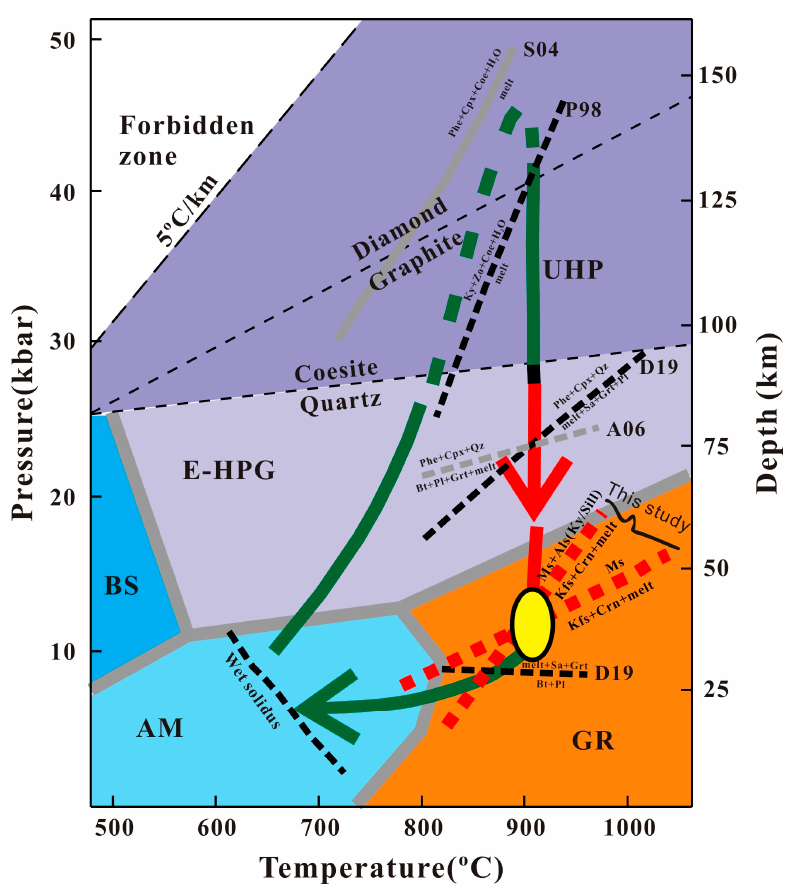
Figure 8. Synthesis of the NDZ P-T path (modified from [70]), with emphasis on the main Figure8. SynthesisoftheNDZP-Tpath(modifiedfrom[70]), withemphasisonthemainmelt-producing melt-producing reactions occurred during isothermal decompression, as inferred from previous reactions occurred during isothermal decompression, as inferred from previous studies (black and grey studies (black and grey dashed curves: S04: [10]; P98, [95]; D19: [70]; A06: [12]) on granulitized dashed curves: S04: [10]; P98, [95]; D19: [70]; A06: [12]) on granulitized eclogites and from this study eclogites and from this study (red dashed curves) on corundum-bearing anatectic gneisses. The (red dashed curves) on corundum-bearing anatectic gneisses. The yellow ellipse refers to the peak P-T yellow ellipse refers to the peak P-T conditions estimated for the corundum-bearing assemblages. conditions estimated for the corundum-bearing